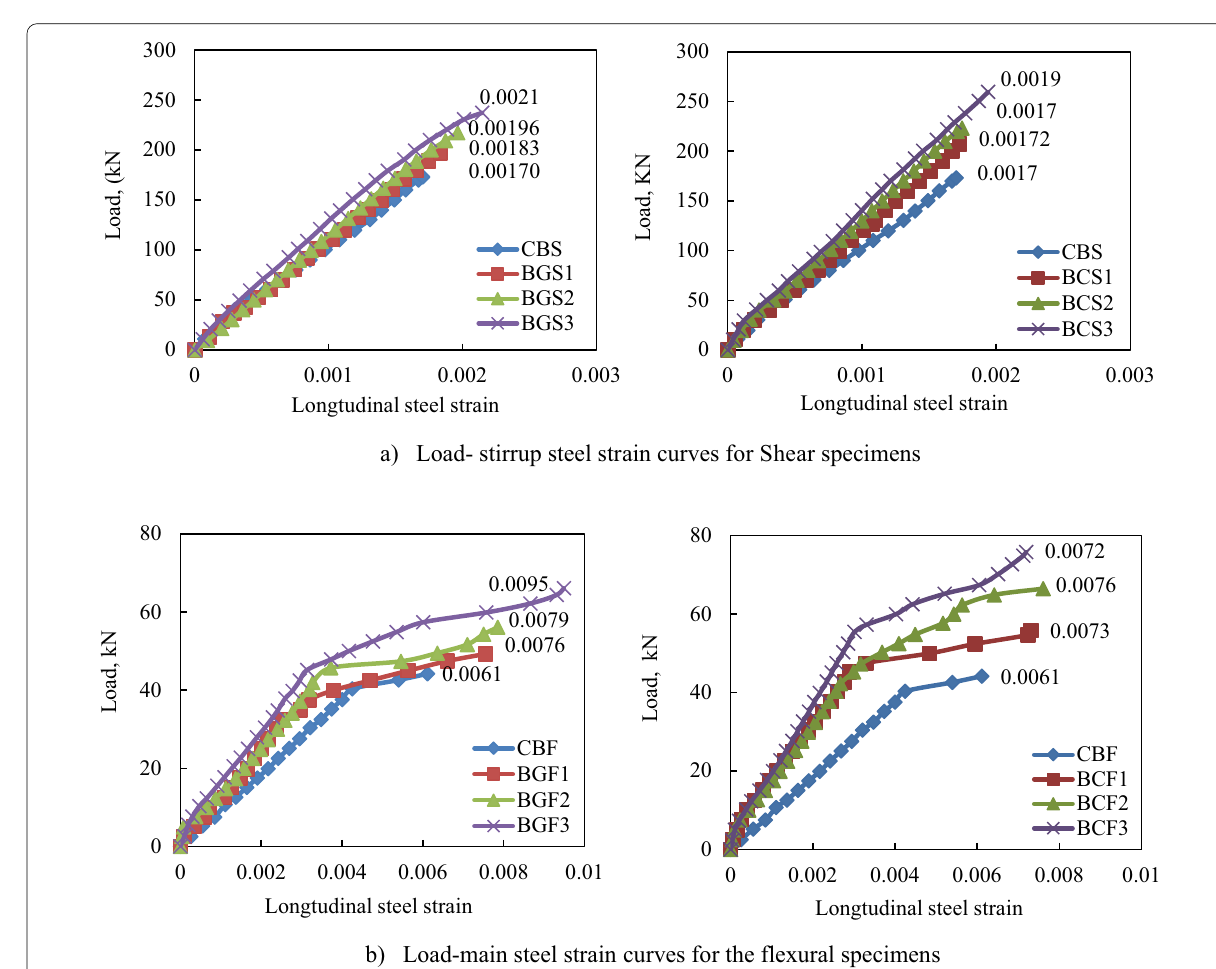
Fig. 12 Load–steel strain curves for all